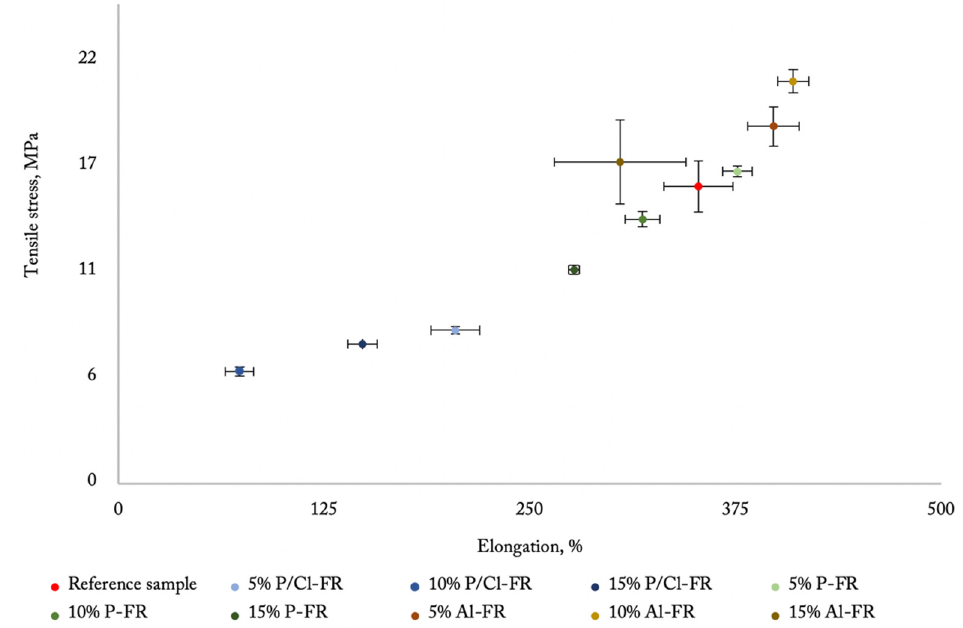
Figure 10. Tensile test of polyurea-based hybrids.